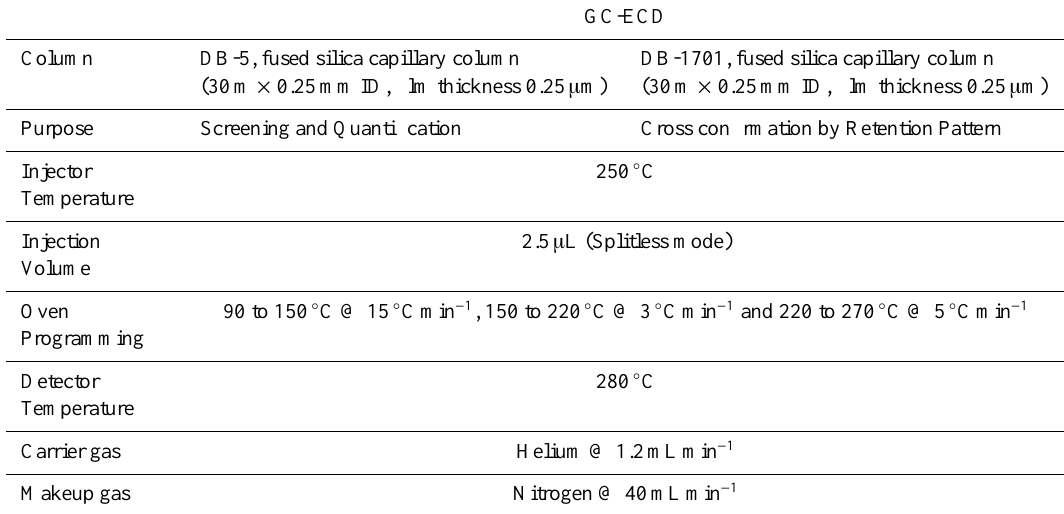
Table 2. Operating conditions used for the operation of GC-ECD (Double column